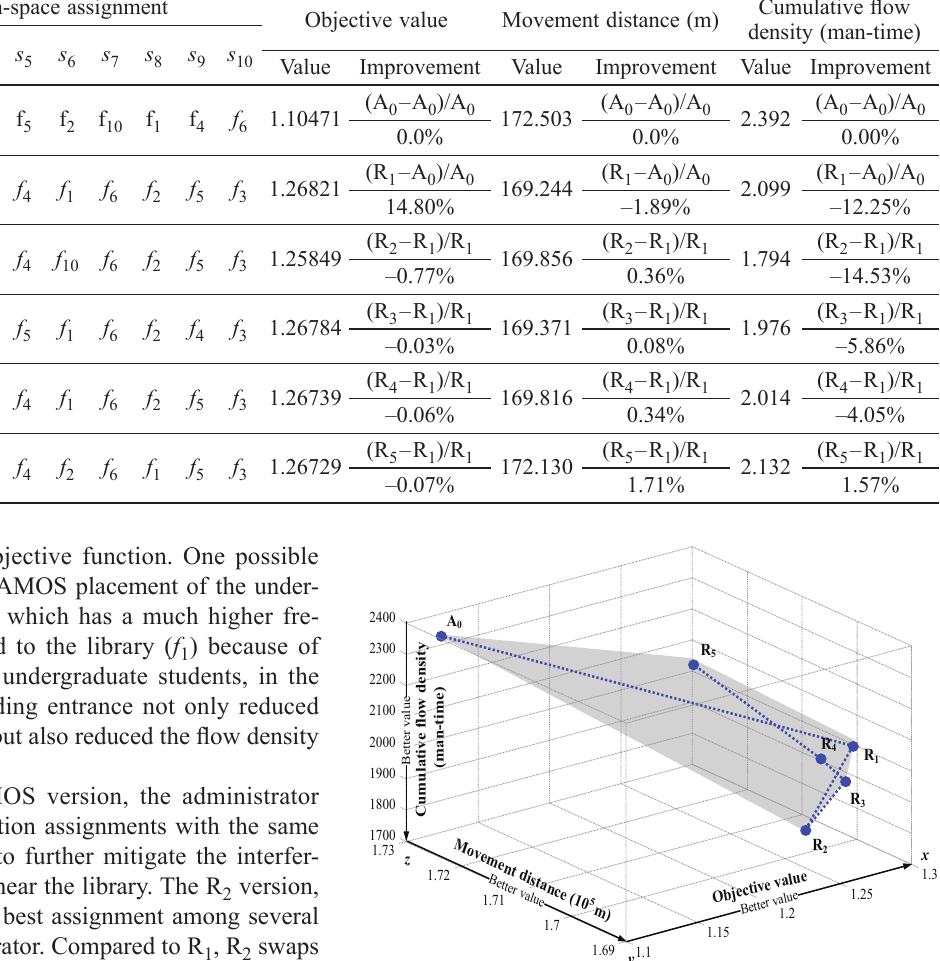
Table 4. Function-space assignments and movement simulation results Results